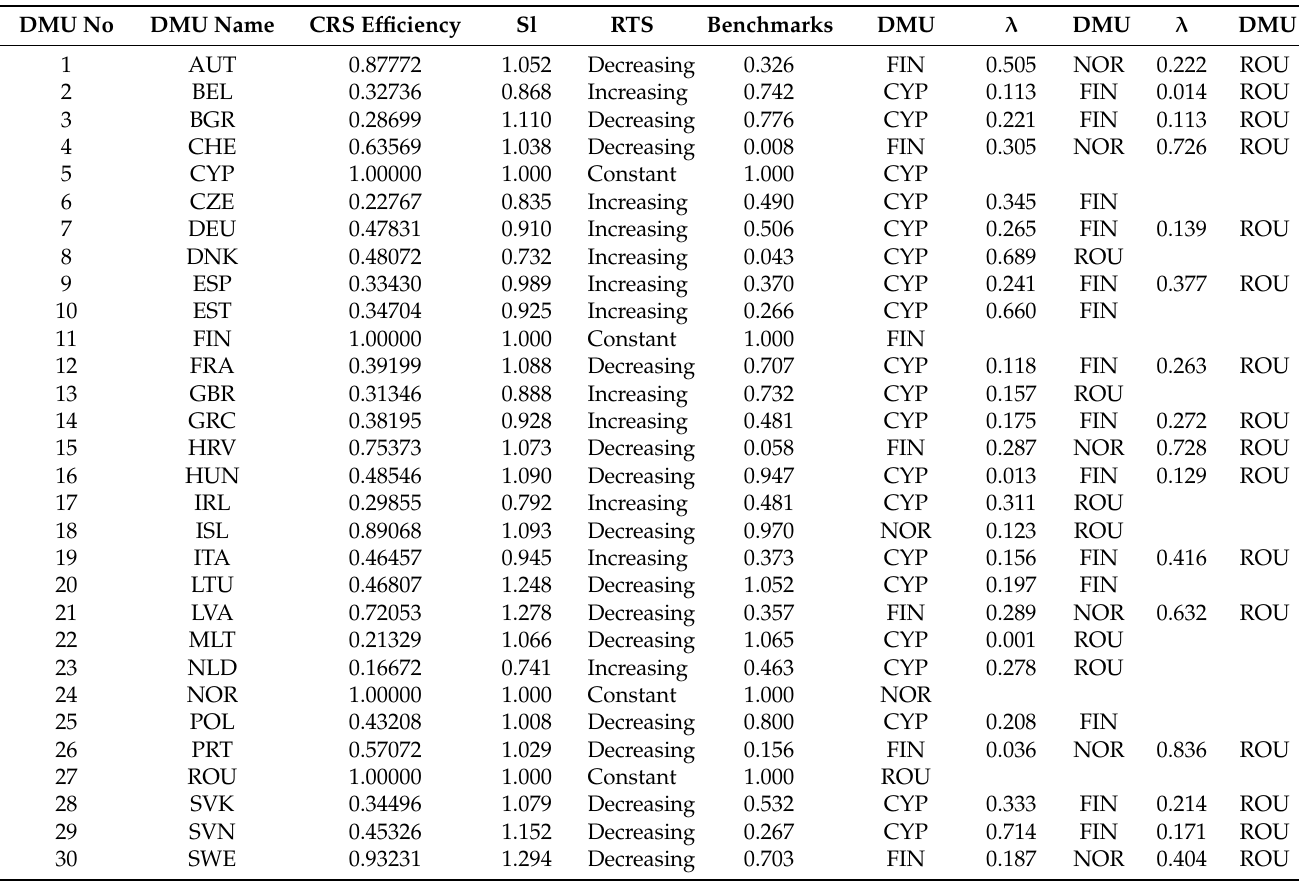
Table A17. Input-Oriented CRS Efficiency of EPS in 2006. Source: Authors’ calculations in DEAFrontier.